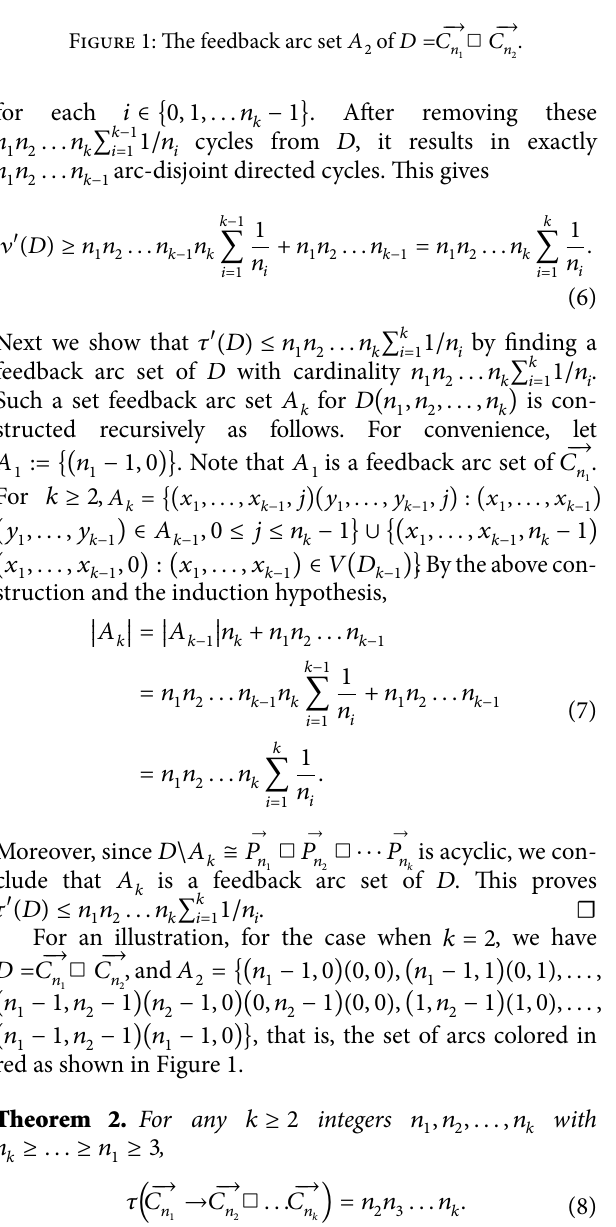
Figure 1: The feedback arc set 𝐴